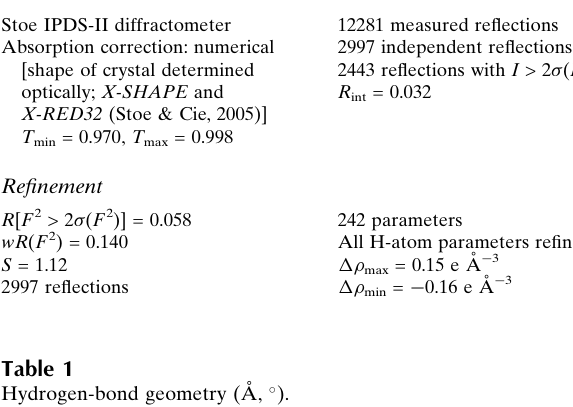
Hydrogen-bond geometry (A˚ , (cid:2)